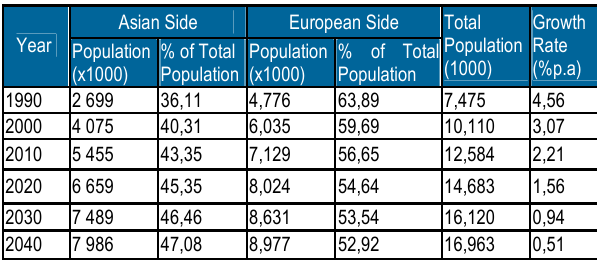
Table 1: The population grow estimated by the water-